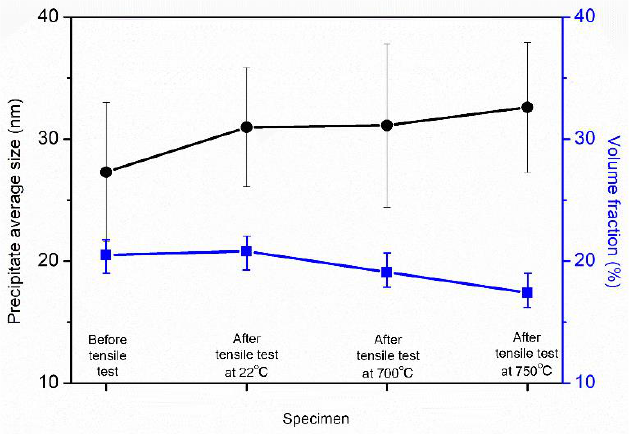
Figure 7. The γ′ precipitate average size and volume fraction evolution before and after the tensile tests at room temperature, 700 °C, and 750 °C.